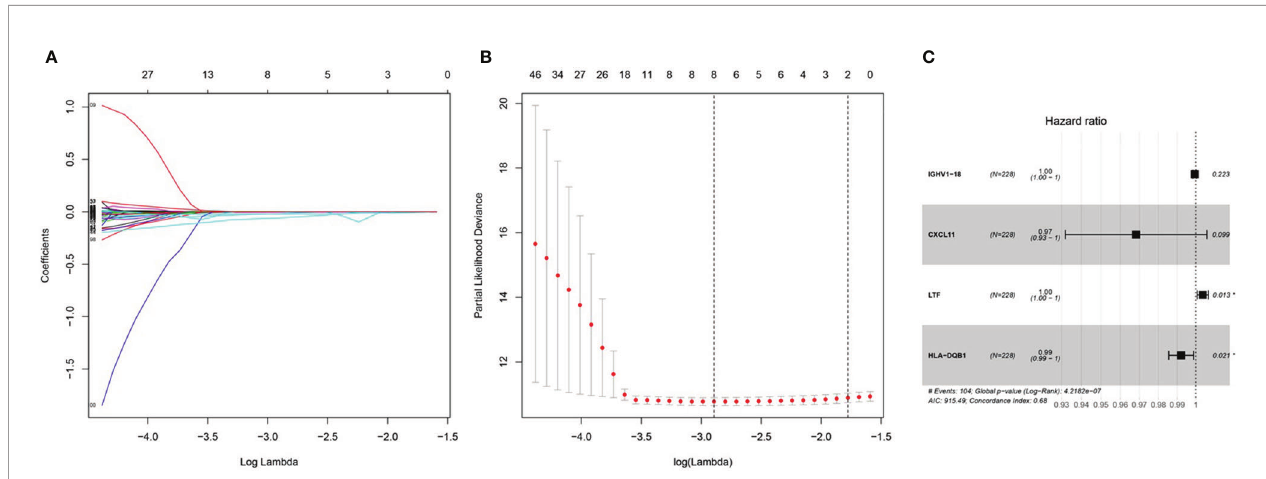
FIGURE 3 | Prognosis model of training cohort. (A, B) LASSO Cox regression analysis of training cohort. (C) multivariate Cox proportional hazards regression analysis of training